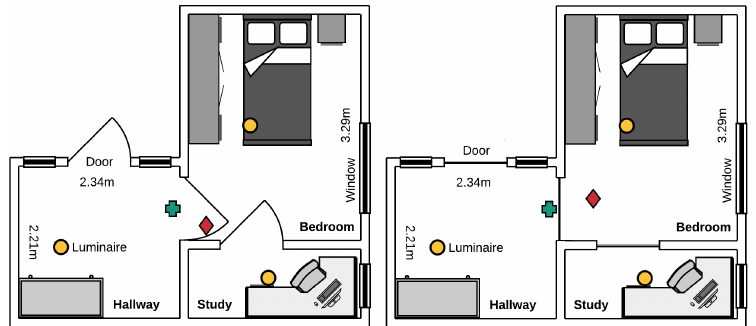
Figure 11. Localisation tests. Luminaires are represented using yellow circles with black border, the person’s real position is represented using the green cross shape and the detected position is shown using the red diamond.